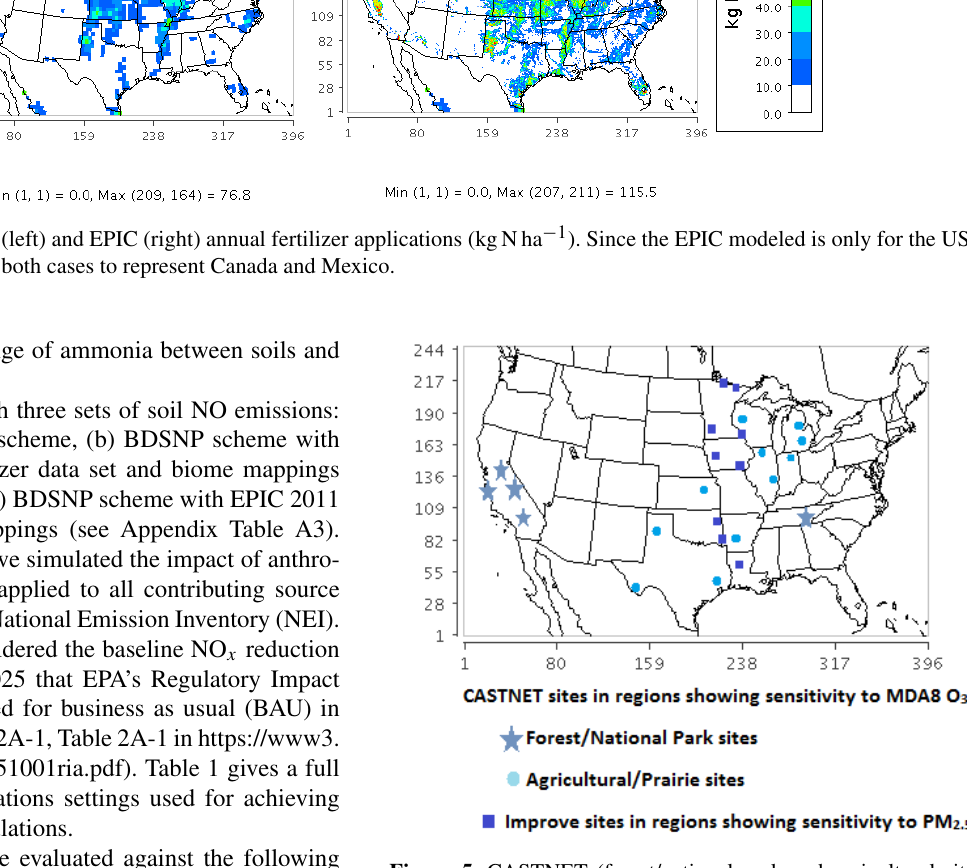
Figure 5. CASTNET (forest/national park and agricultural sites) and IMPROVE sites in continental USA for comparison of modeled and observed ozone and PM 2 . 5